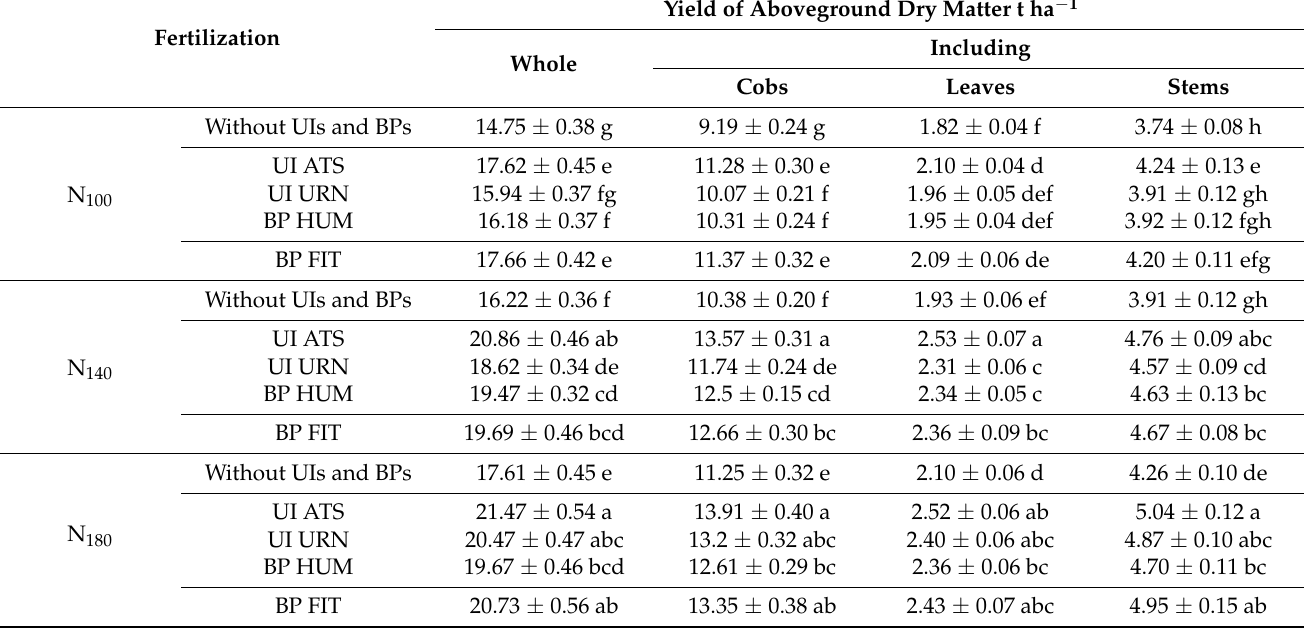
Table 7. The influence of different nitrogen fertilizer rates, urease inhibitors, and biological prepara- tions on the dry matter yield and yield structure of maize in